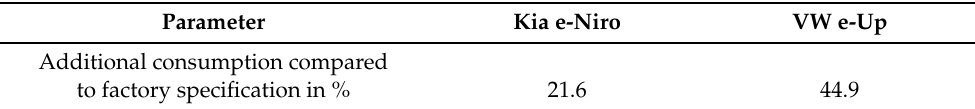
Table 5. Additional energy consumption compared to the factory specification.